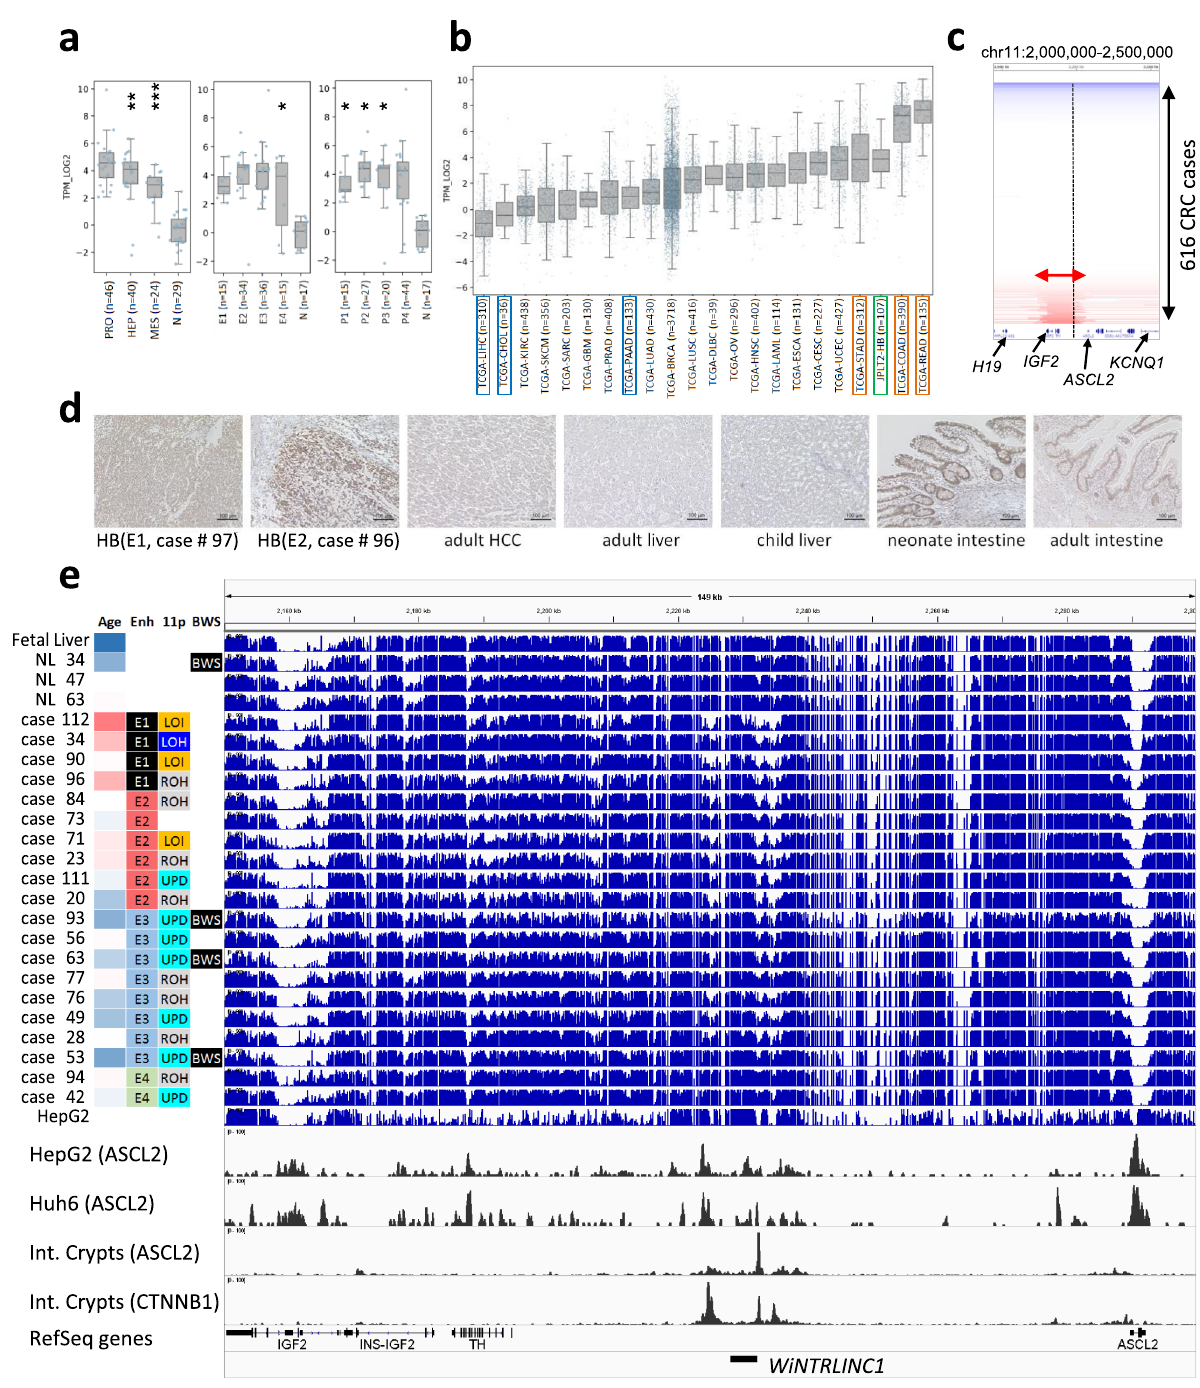
Fig. 5 Aberrant hypomethylation in the ASCL2 region. a Expression level of ASCL2 in hepatoblastoma (HB) in this study The center lines show the medians, the tops, and bottoms of boxes show quartiles, and the whiskers show the extremes within the range of the medians ± 1.5 × the interquartile ranges, wherein * p < 0.05, ** p < 0.01, *** p < 0.001, **** p < 0.0001. Statistical signi fi cance was analyzed using a two-sided Fisher ’ s exact test. Gene expression subgroup (left), PRO vs. N, p = 0.221; HEP vs. N, p = 0.004; MES vs. N, p < 0.001, Enhancer methylation subgroup (middle), E1 vs. N, p = 0.229; E2 vs. N, p = 0.576; E3 vs. N, p = 0.351; E4 vs. N, p = 0.047; Promoter methylation subgroup (right), P1 vs. N, p = 0.013; P2 vs. N, p = 0.041; P3 vs. N, p = 0.025; P4 vs. N, p = 0.408. b Expression level of ASCL2 in hepatoblastoma (HB) in this study and adult cancers in TCGA Pan-Cancer project. c Recurrent focal ampli fi cation in IGF2/ASCL2 region in TCGA colorectal carcinoma. d Immunohistochemical staining of ASCL2 using 100× diluted anti- ASCL2 rabbit polyclonal antibody (Biorbyt Ltd, Cambridge, UK), in the series of human liver, intestine, and tumor samples. This immunological analysis was repeated independently one other time with a similar result. e Landscape of the methylation statuses of the IGF2/ASCL2 regions analyzed using whole- genome bisul fi te sequencing (blue bar graphs, 21 HB, 3 normal livers, and the liver cancer cell line, HepG2). The bottom two rows (black) represent the ChIP-sequencing data ( CTNNB1 and ASCL2 ) obtained using the human intestinal crypts 35 and hepatoblastoma cell lines, HepG2 and Huh7. Clinical and molecular parameters (Age age at diagnosis, Enh enhancer methylation subtype, 11p copy number status of chromosome 11p, BWS Beckwith – Wiedemann syndrome) are shown on the left of the bar